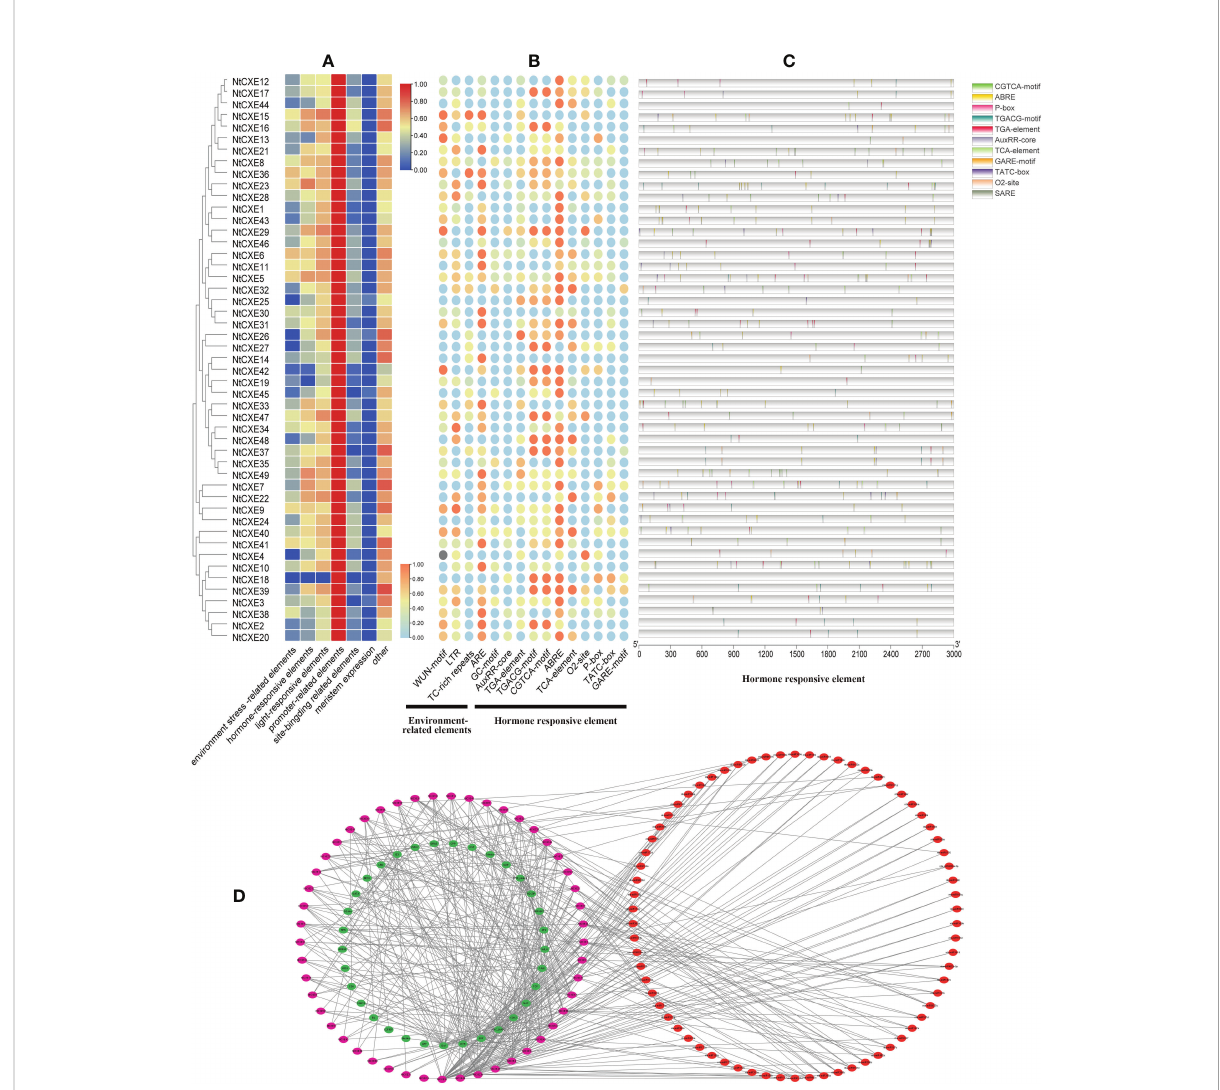
FIGURE 4 Analysis of promoters and interaction network of the tobacco NtCXE genes. (A) Predicted cis -acting elements divided into six types for each NtCXE promoter using PlantCARE software. Heat maps were drawn by TBtools using FPKM mean values. Color represents the gene expression levels (red, high expression level; and blue, low expression level). (B) Prediction of the magnitude of elements related to hormone and environmental stress in NtCXE promoters. The heat map is drawn in the same way as fi gure A (orange, high expression level; and blue, low expression level). (C) Position, type, and number of hormone-related elements in NtCXE promoters using “ TBtools ” . (D) Regulation network of NtCXE s in tobacco plants. The purple, green, and red circles denote NtCXE genes, transcription factors (TFs), and miRNAs,